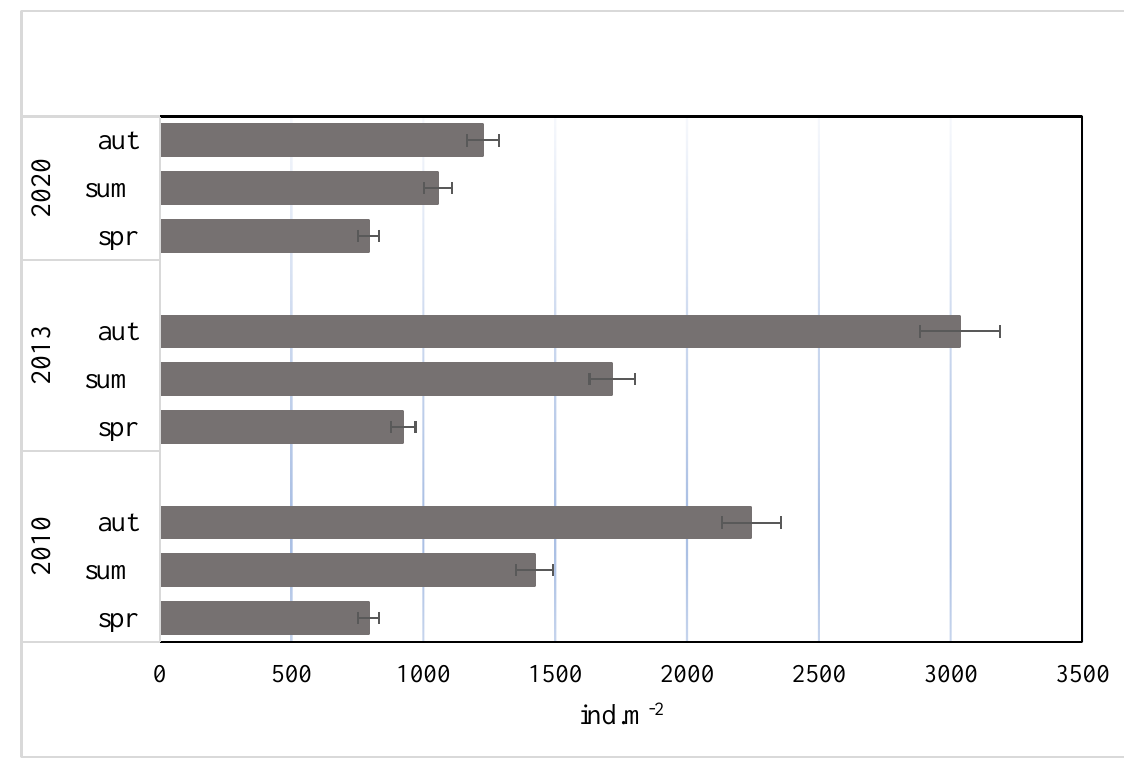
Figure 1. Seasonal changes of mean densities ( ± SD) of macroinvertebrates in peat pool habitat during 10 years of